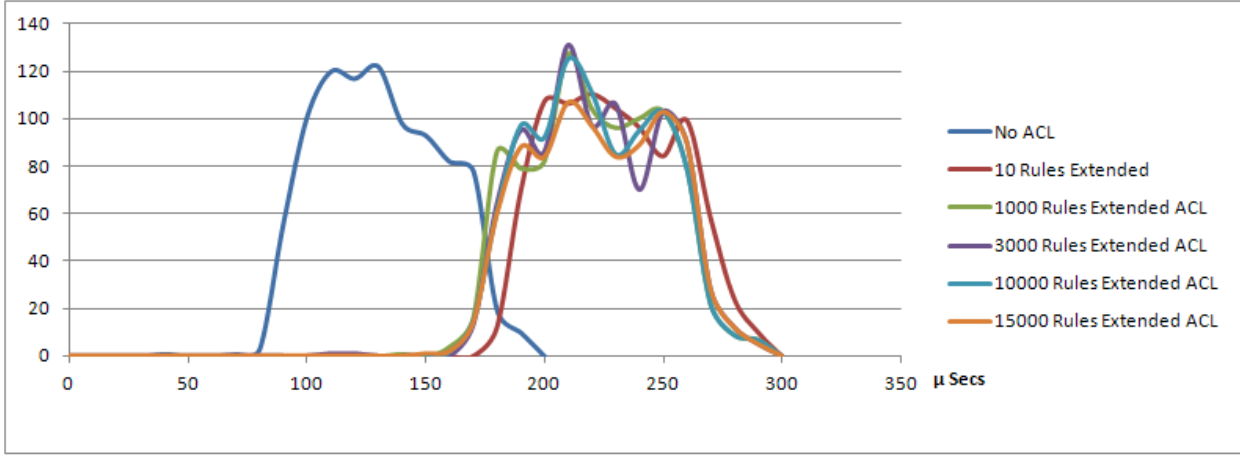
Figure 5. Delay through router with Advanced